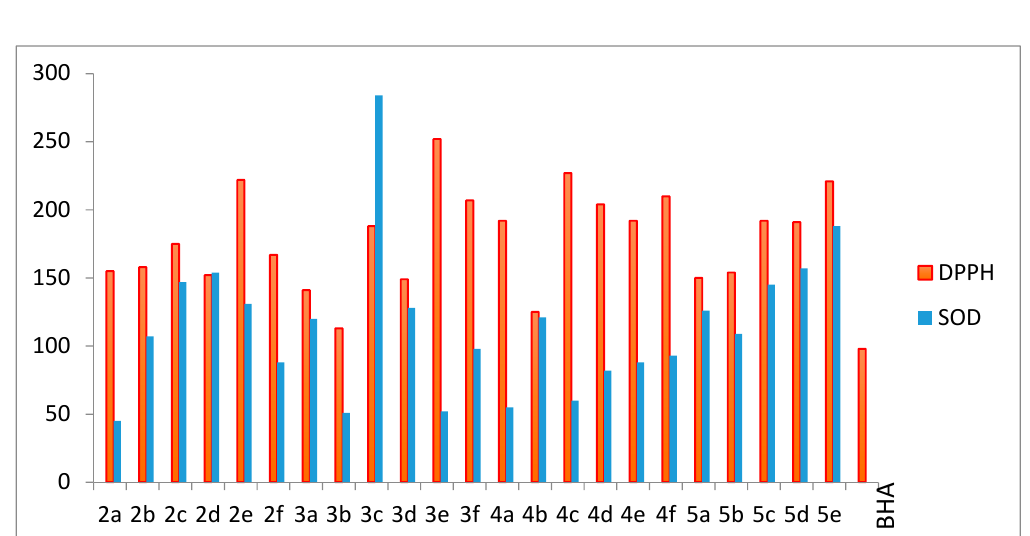
Figure 2. Graphical representation of the antioxidant activity of the tested compounds.